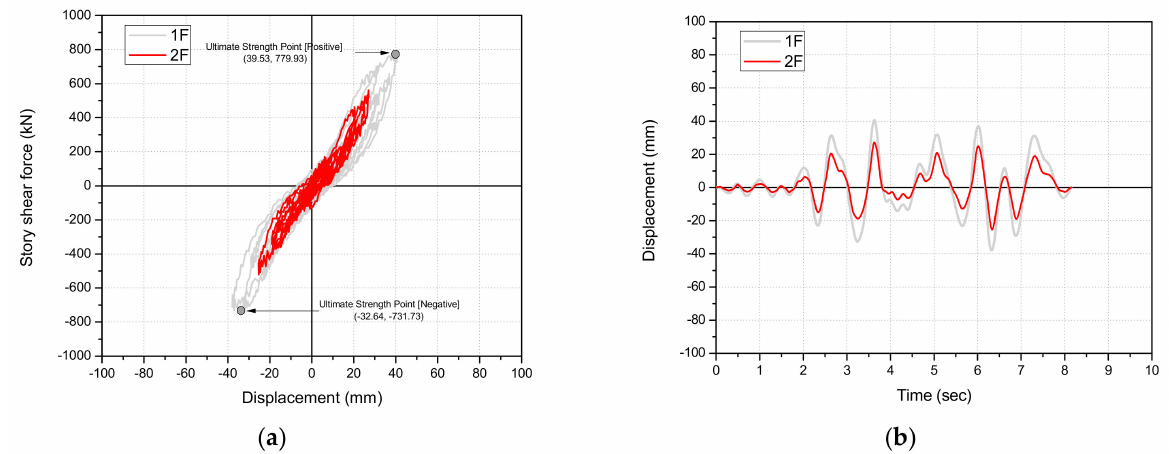
Figure 17. Seismic response load-displacement and displacement-time hysteresis curves (PD-CFT-MF, 400 cm/s 2 ): ( a ) load- displacement curves; ( b ) displacement-time hysteresis